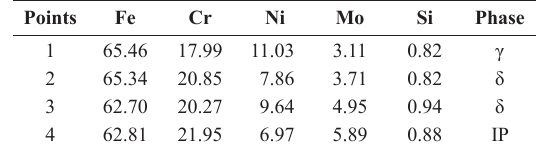
Table 6. Chemical composition of the points identified by EDS in Figure 5a